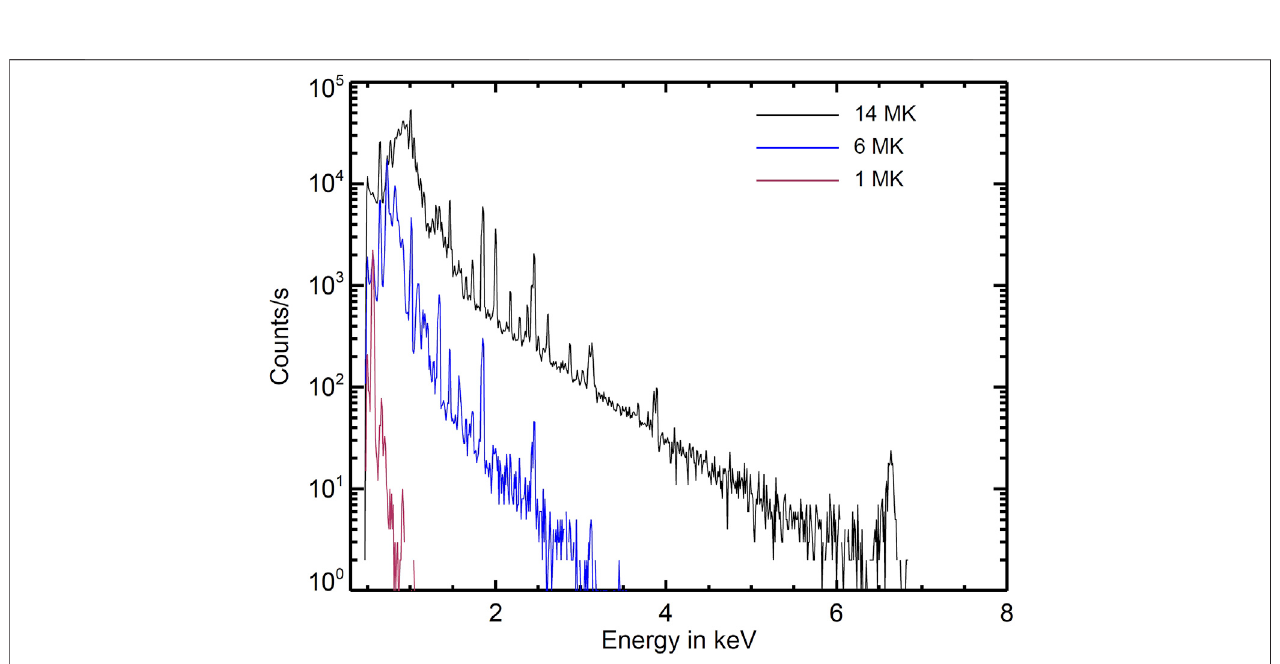
FIGURE6| Expectedsolarspectruminspectrometermode(combinedforthefourchannels)oftheinstrument.Thespectrumisgeneratedforasingletemperature plasma using the Astrophysical Plasma Emission code based on AtomDB atomic data base.